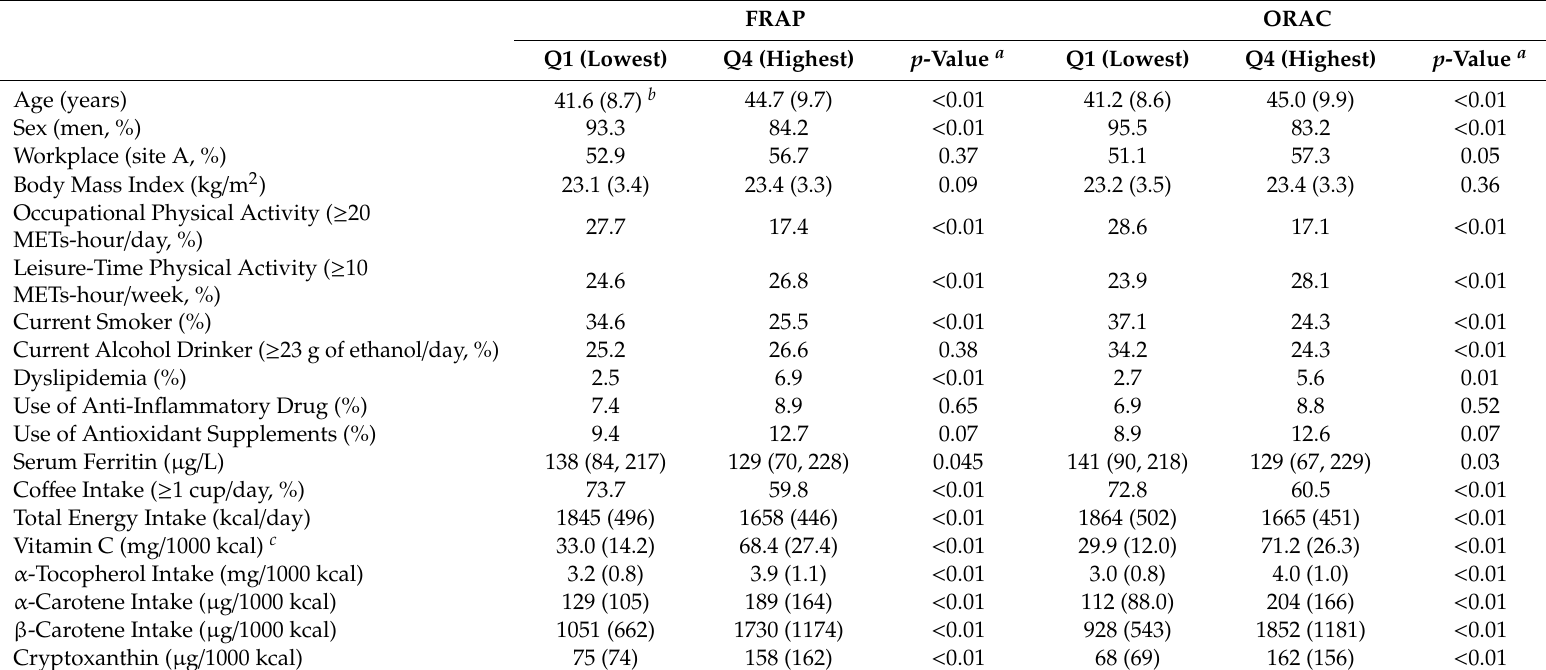
Table 2. Characteristics of participants according to quartiles of dietary